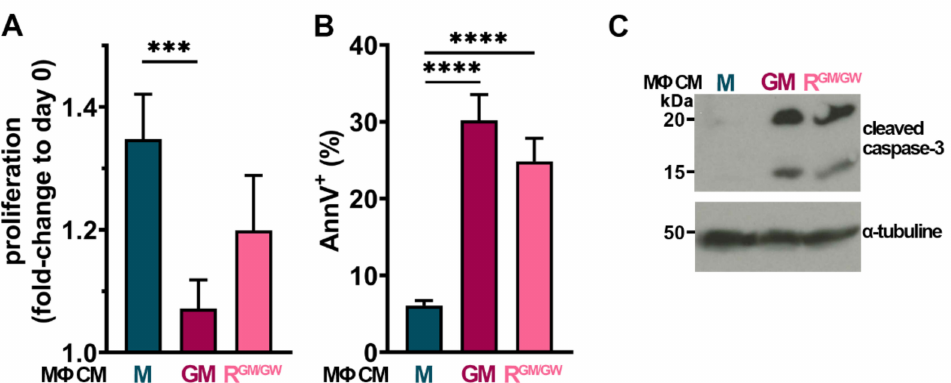
Figure 6. GM- and R- M Φ CM impair U937 proliferation and induce their apoptosis. ( A , B ) U937 cells were cultured in PM supplemented with 25% M Φ CM and counted after 24 h, n = 5–8 ( A ) or analyzed by FC with AnnV staining, n = 7–13 ( B ). The mean + SEM is plotted for each condition. *** p < 0.001, and **** p < 0.0001 (M-W test). ( C ) Lysates from 10 6 U937 cells cultivated for 48 h with indicated M Φ CM were immunoblotted with anti-cleaved caspase-3 antibody (upper panel) or anti- α -tubulin (lower panel) antibody as